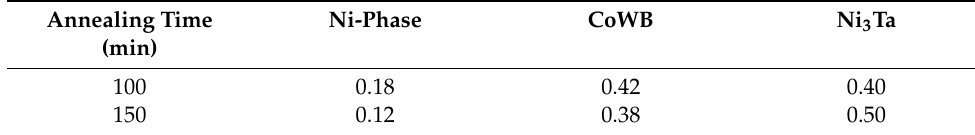
Table 2. The volume fractions of the phases precipitated in the